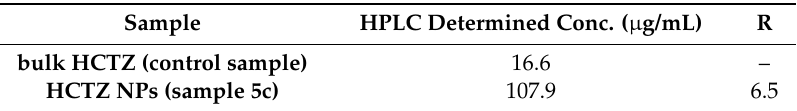
Table 2 . Results of dissolution test.